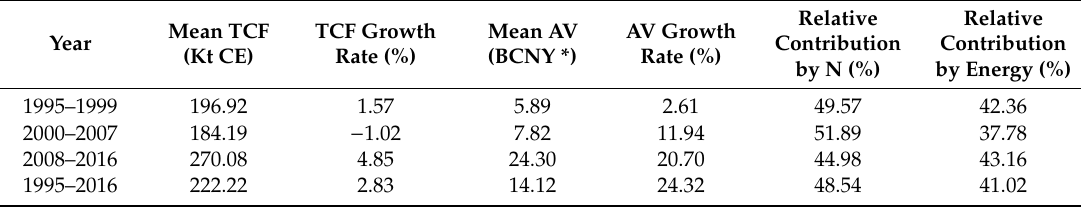
Table 2. Mean TCF and mean agricultural output values for four periods.